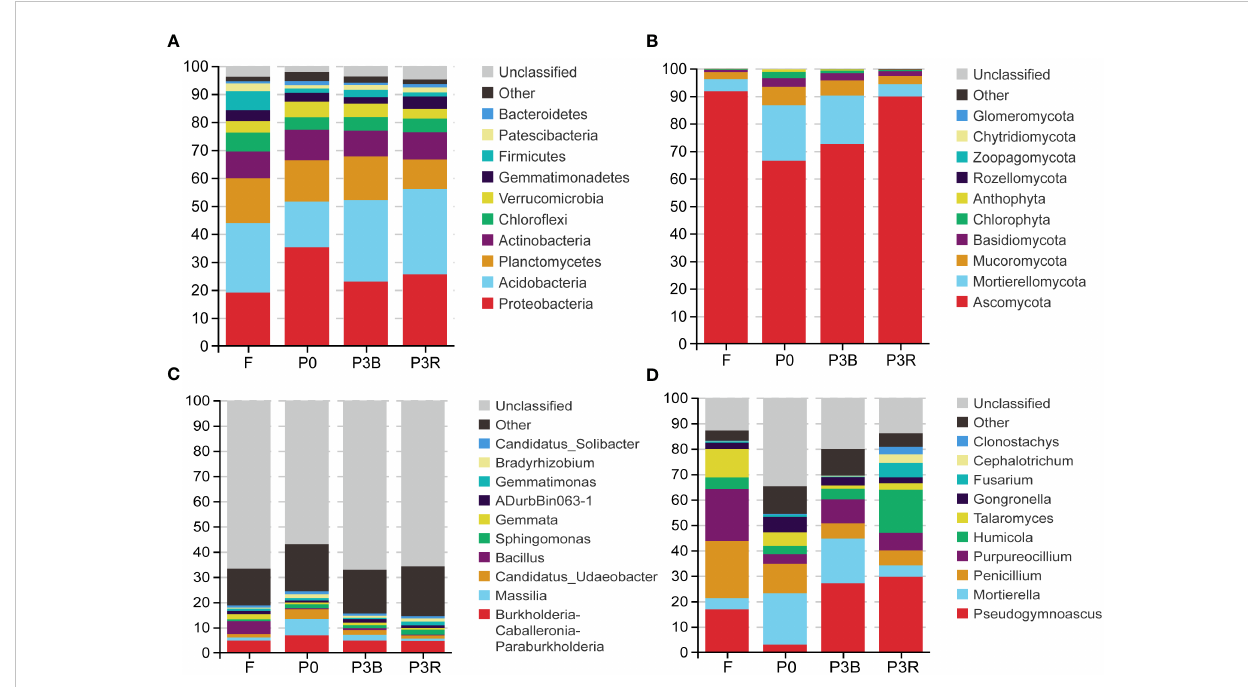
FIGURE 5 Relative abundances of the top 10 microbial phylum and genus levels. (A, C) Bacteria; (B, D) Fungi; (A, B) phylum levels; (C, D) genus levels. P0, control soil; F, one-year fallow soil; P3R, Rhizosphere soil after three years consecutive monoculture; P3B, Bulk soil after three years consecutive